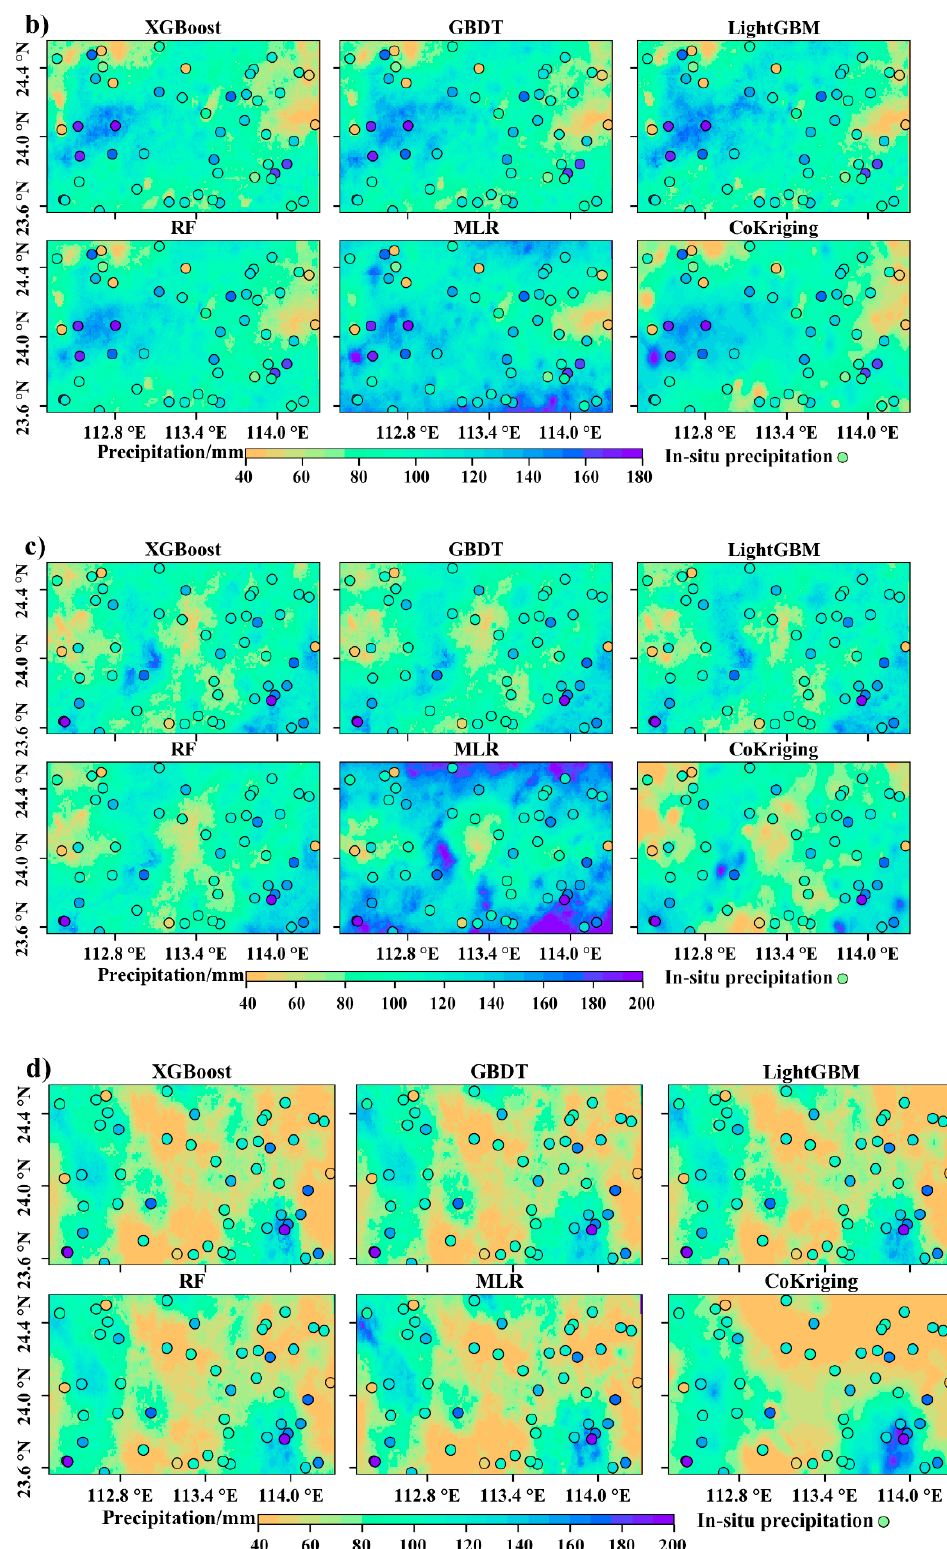
Figure 13. Spatial distribution of the accumulated precipitation merging results of different merging methods for the four heavy rainfall events: ( a ) heavy rainfall event I, ( b ) heavy rainfall event II, ( c ) heavy rainfall event III, and ( d ) heavy rainfall event IV.